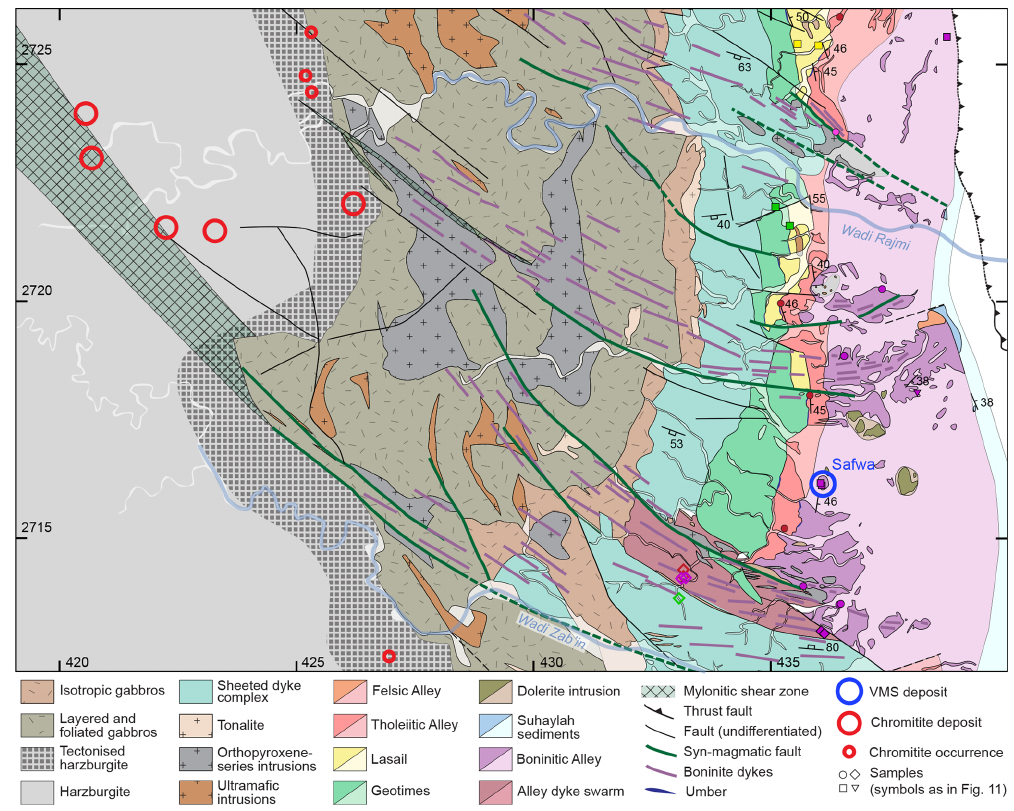
Figure 16. Boninites capping the volcanic succession in the Wadi Rajmi and Wadi Zab’in region and their structural connection to previ- ously mapped boninite dykes, ultramafic and orthopyroxene-series intrusives (Adachi and Miyashita, 2003; BRGM, 1993b; Umino et al., 1990; Usui and Yamazaki, 2010), mantle shear zones (Boudier and Al-Rajhi, 2014; BRGM, 1993b; Takazawa et al., 2003), and podiform chromitites (Boudier and Al-Rajhi, 2014; BRGM, 1993b; Rollinson, 2008). The boninite-hosted Safwa VMS deposit is also shown (Gilgen et al., 2014). Coordinate grid: UTM 40 N in kilometres. Sample symbology as in Fig. 11. Strong colours denote outcrops; pale conjugate colours denote inferred bedrock beneath